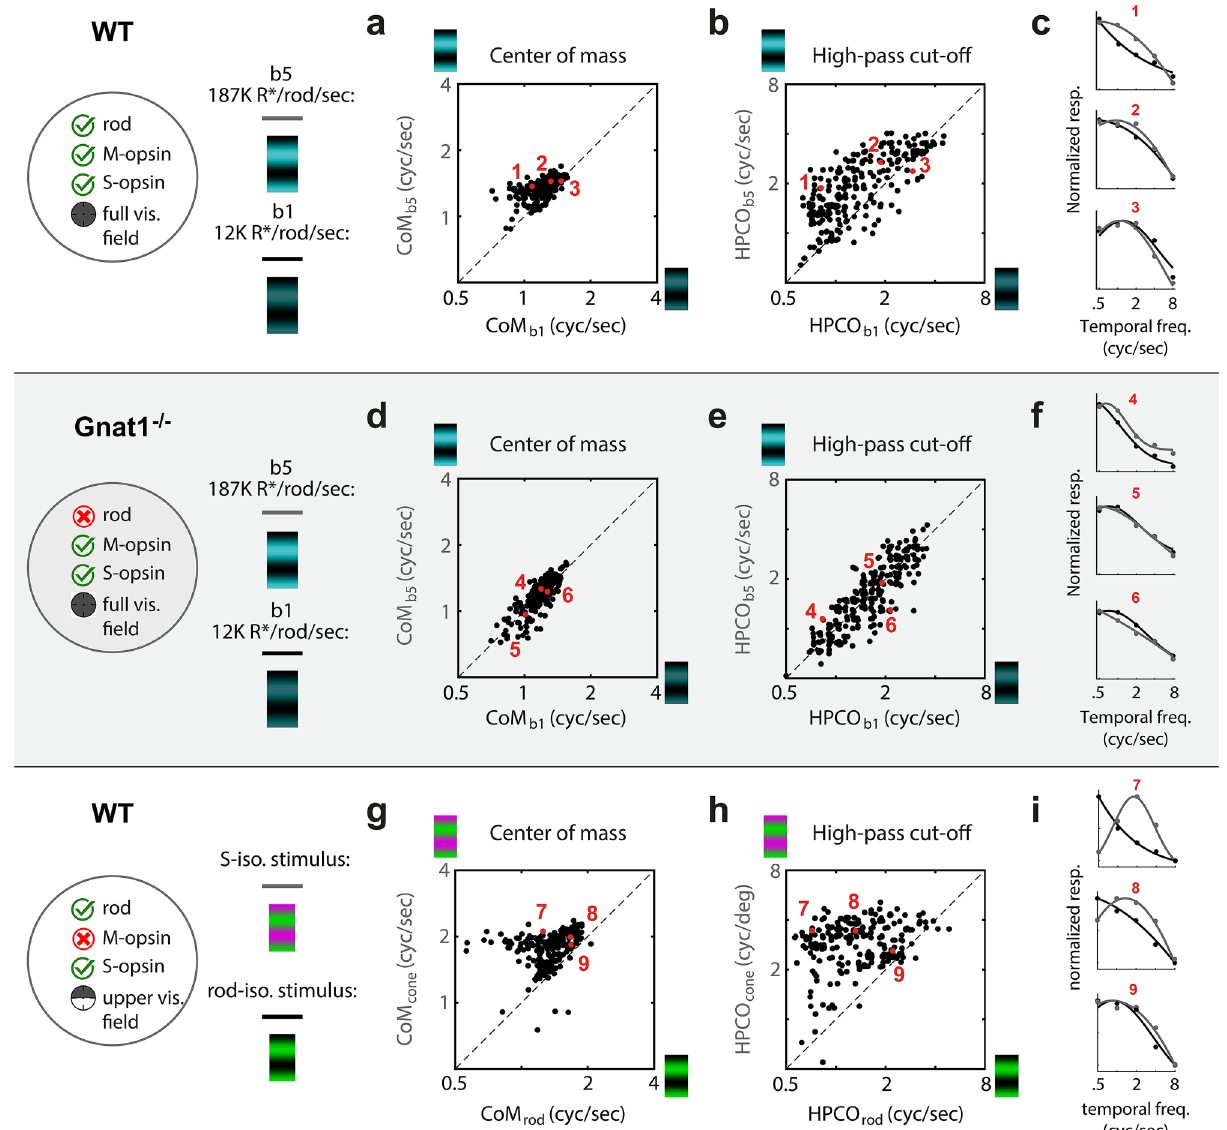
Figure 5. V1 responds to higher temporal frequencies when stimuli drive cones more than rods. Top row (‘a- c’) is data from WT mice, comparing temporal frequency tuning at two light adaptation levels, “b1” and “b5”, corresponding to 12 K and 187 K R*/rod/sec (n = 235). ( a ) Scatter plot compares the temporal frequency tuning curve’s center-of-mass (CoM) at b5 (y-axis) and b1 (x-axis). Unity line is dashed black line. The geometric mean of CoM b5 /CoM b1 is 1.12 (i.e. 12% change; t-test: p = 2.47e −35 ). ( b ) Same as in ‘a’, but the temporal frequency tuning parameter is the high-pass cut-off frequency (HPCO). The geometric mean of HPCO b5 /HPCO b1 is 1.38 (t-test: p = 1.76e −32 ). ( c ) Tuning and fits of 3 example neurons at the 5th, 50th, and 95th percentile of the HPCO b5 /HPCO b1 distribution from ‘b’. Dots are normalized responses and lines are the fits. In each case, black and gray correspond to ‘b1’ and ‘b5’, respectively. Next, middle row of panels (‘d-f’) shows data from rod- deficient Gnat1 −/− mice, using the same experiment and analysis as in the top row (n = 244). ( d ) The geometric mean of CoM b5 /CoM b1 is 1.00 (t-test: p = 0.012). ( e ) The geometric mean of HPCO b5 /HPCO b1 is 1.01 (t-test: p = 0.0047). ( f ) Tuning and fits of 3 example neurons at the 5th, 50th, and 95th percentile of the distribution of HPCO b5 /HPCO b1 from ‘e’. Bottom row of panels (‘g-i’) shows data from WT mice, limited to neurons with a receptive field 30-deg above the retina’s midline where opsin expression is mostly limited to S-opsin and rhodopsin (n = 218). Here, background light levels were held constant at b5 and tuning was compared between stimuli of isolating cone- and rod-contrast. ( g ) Scatter plot compares temporal frequency tuning CoM between the rod (x-axis) and cone (y-axis) isolating contrasts. Geometric mean of CoM cone /CoM rod is 1.42 (t-test: p = 1.91e −31 ). ( h ) Same as in ‘g’, but the parameter measurement for each neuron and light level is HPCO. Geometric mean of HPCO cone /HPCO rod is 2.54 (t-test: p = 1.97e −51 ). ( i ) Tuning and fits of 3 example neurons at the 5th, 50th, and 95th percentile of the distribution of HPCO cone /HPCO rod